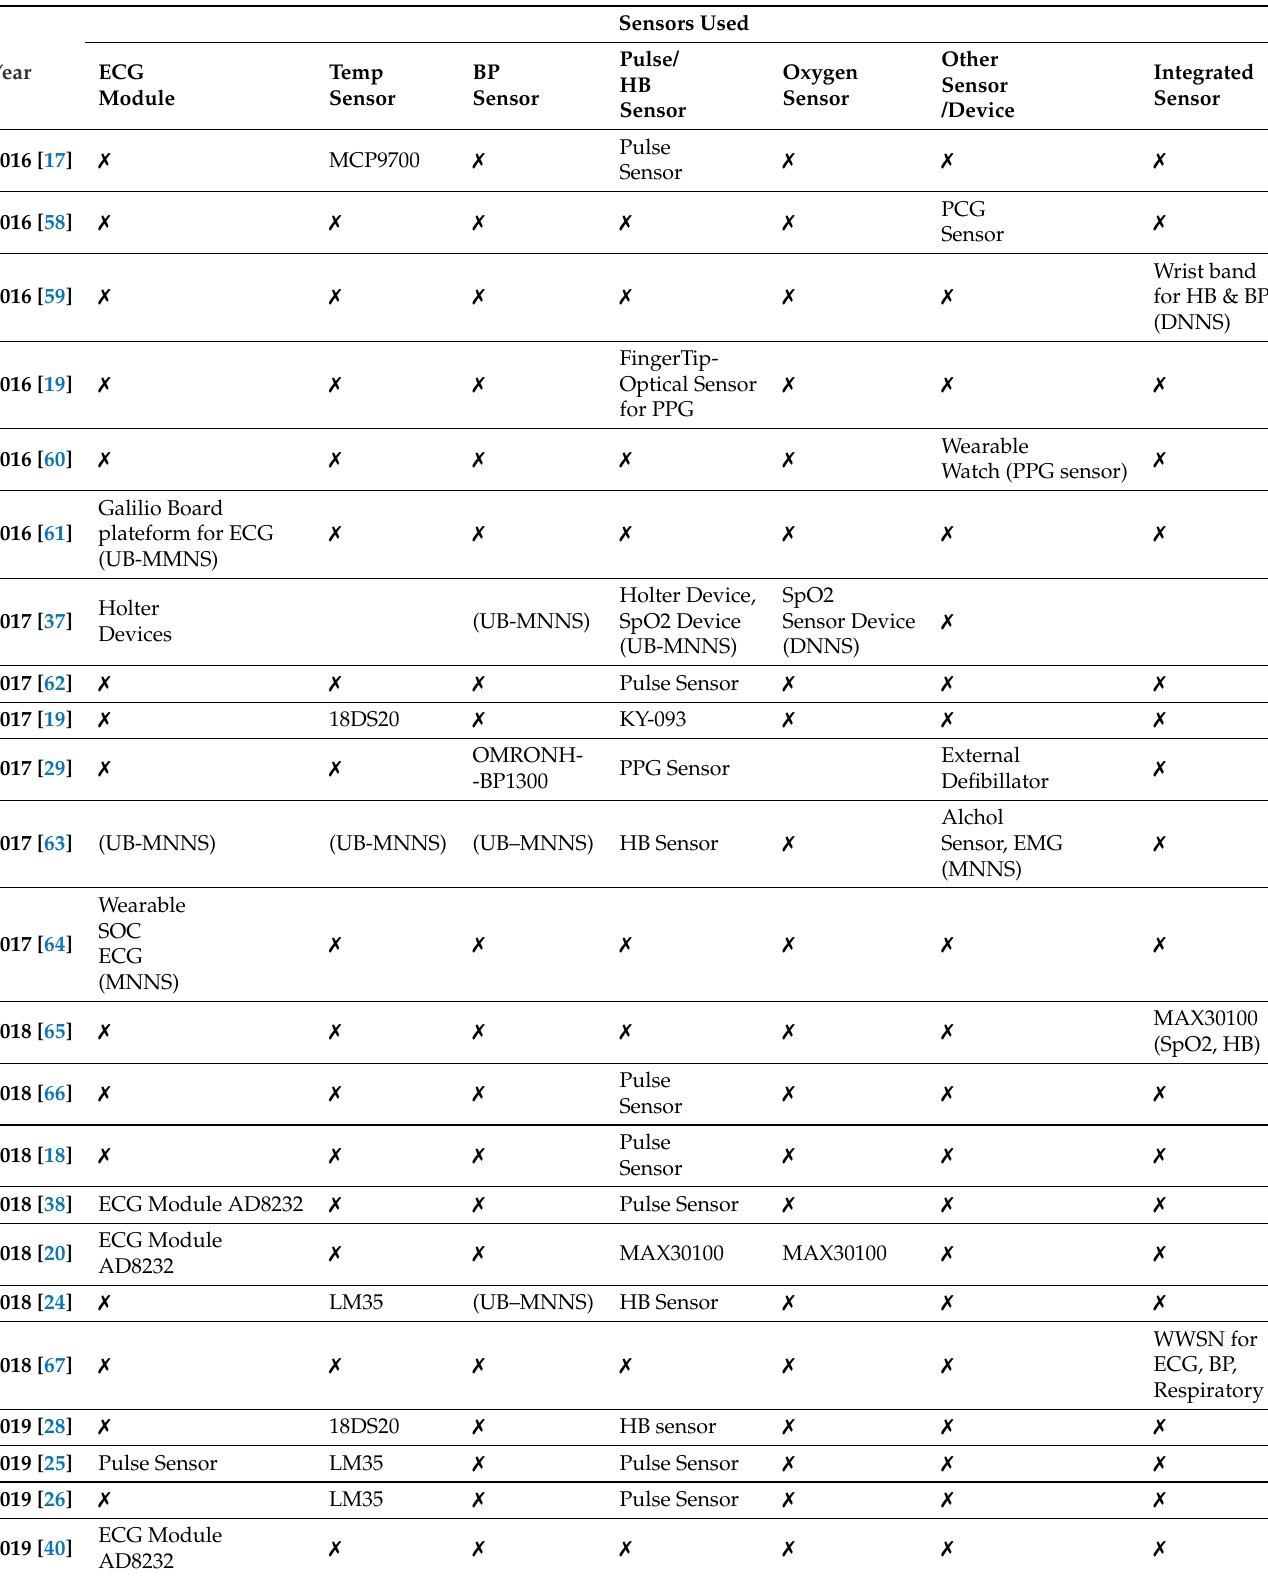
Table 10. Sensors used in previous studies.